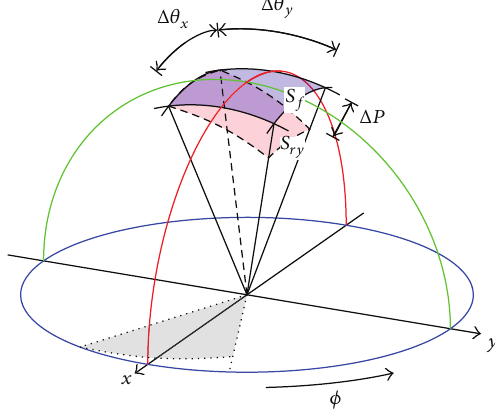
Figure 2: 2D tracking shapes 𝑆 𝑓 and 𝑆 𝑟𝑦 visualized in (𝜙,𝜃) .